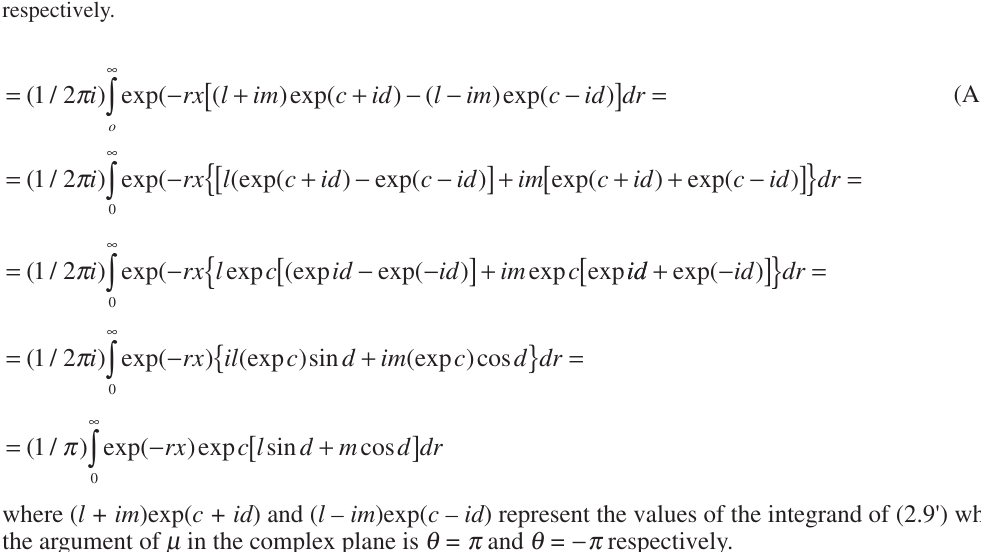
Fig. A.1. Path of integration in the complex plane LT